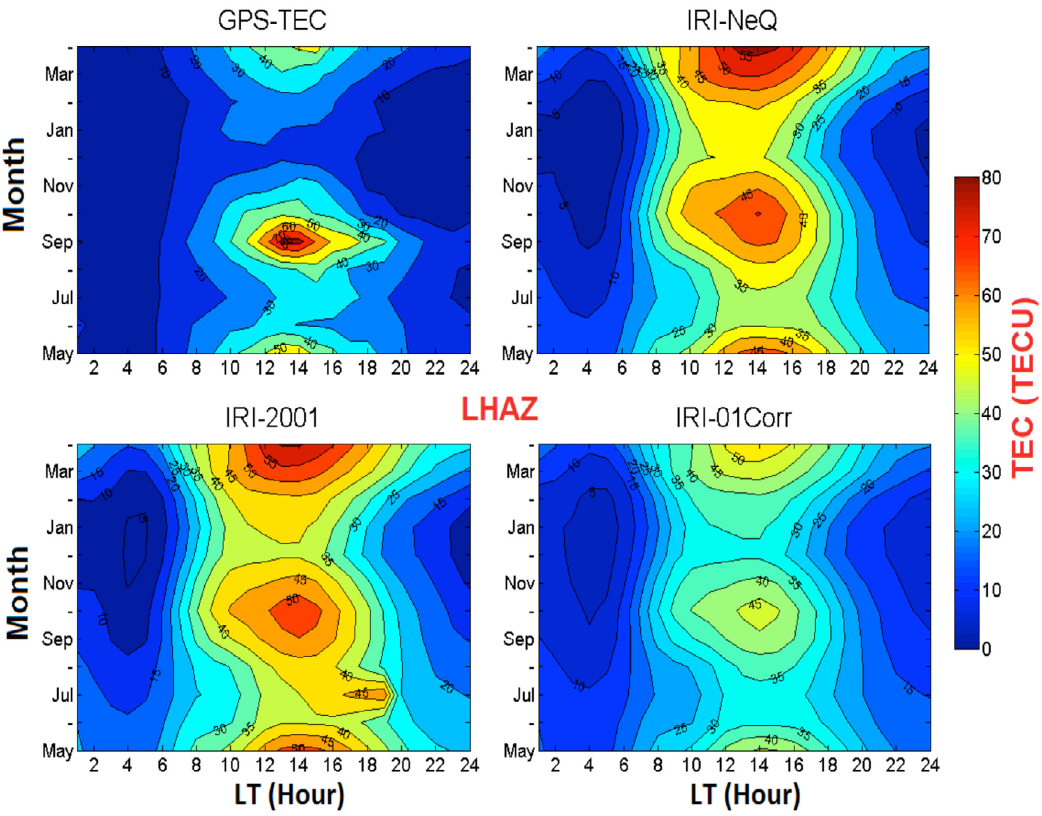
Figure 5. Contour diagram of monthly mean variation of GPS-TEC, IRI 2012 model TEC (NeQuick, IRI- 2001 and IRI-01-corr) at Lhasa (LHAZ) (Geomagnetic lat. 20.09°N) from May 2012 to April